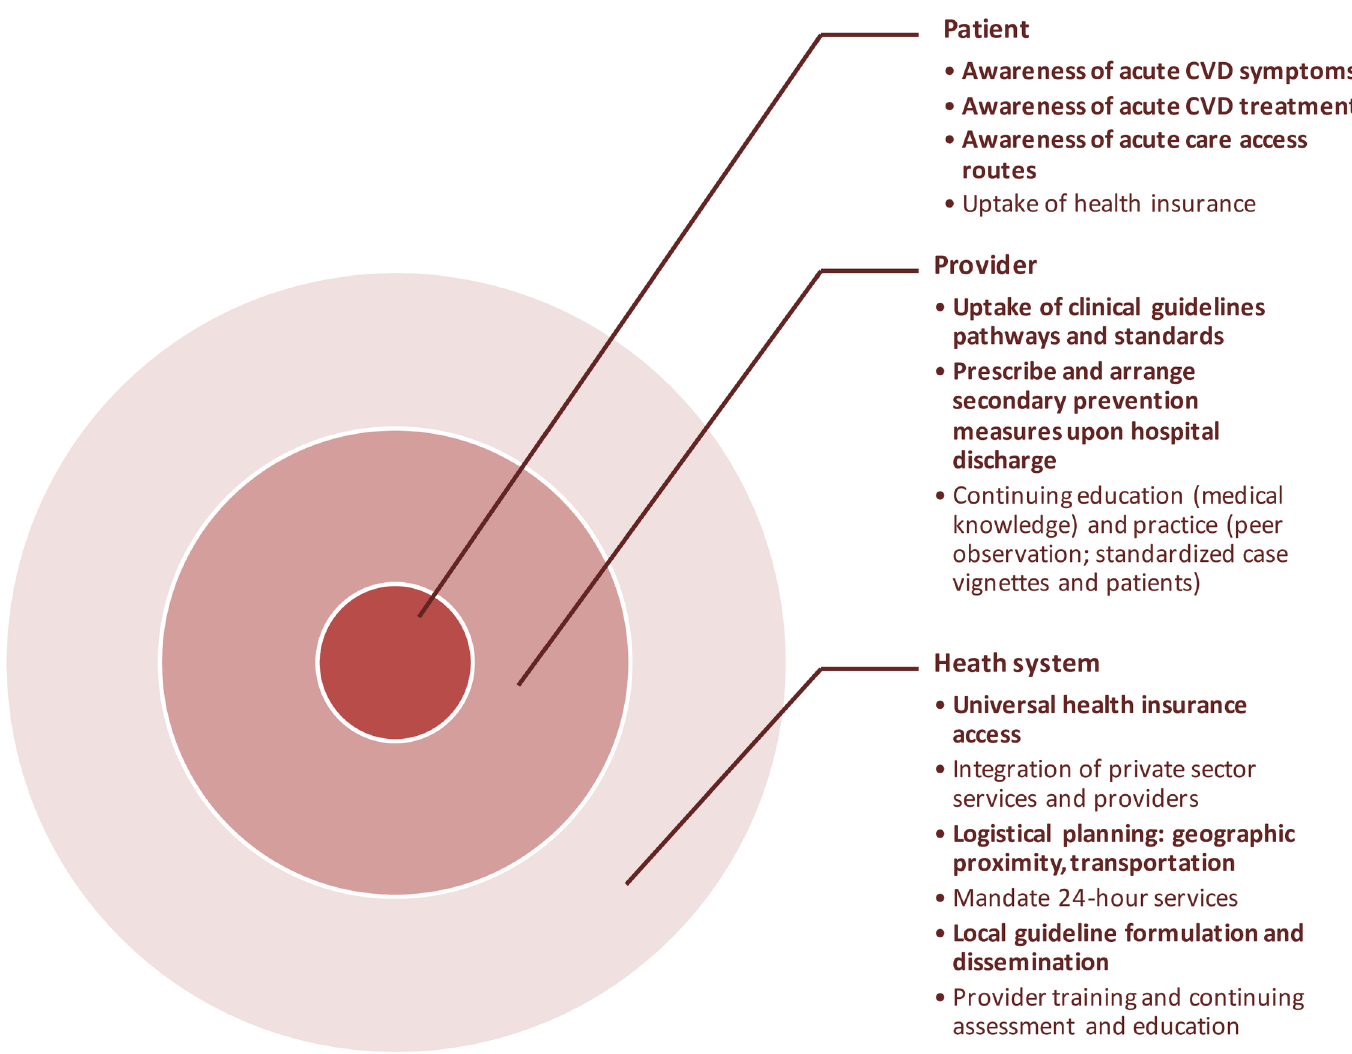
Fig 3. Examples of acute phase CVD quality improvement interventions identified in the DCP3 systematic review. Types of interventions targeting three levels of acute phase CVD prevention and management. Bullets in bold type are supported by evidence from the review. Bullets without bold type indicate that no supporting evidence was found in the review and are potential areas for further